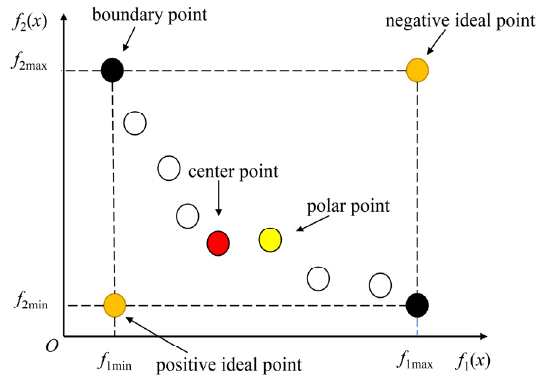
Figure 2. Schematic diagram of key points.